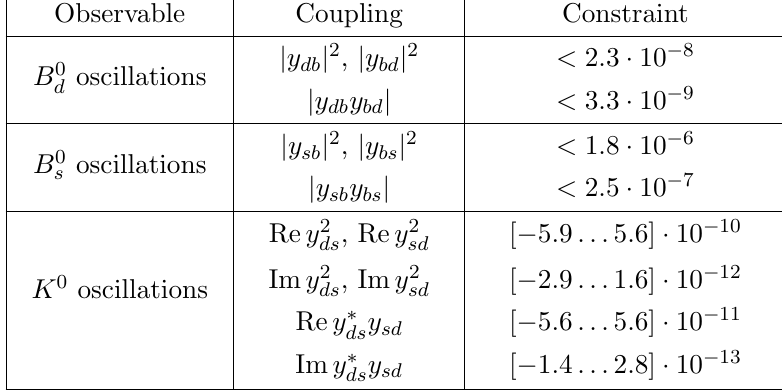
Table 1. Current 95 % con(cid:12)dence level (CL) limits on the Wilson coe(cid:14)cient of eq. (2.2) from meson oscillations experiments. The reported bounds are taken from